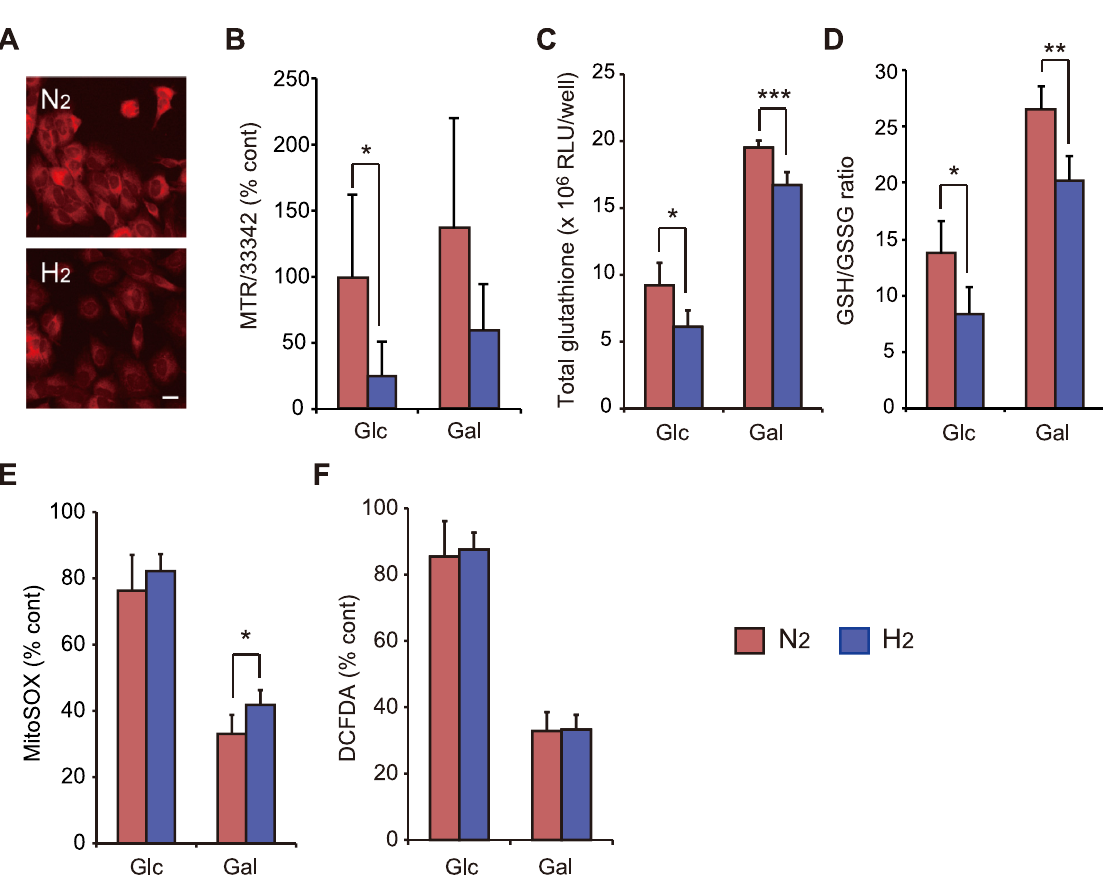
Fig 4. Induction of oxidative stressby H 2 treatment. SH-SY5Y cells were incubatedin culture medium containingeither Glc or Gal under N 2 - or H 2 -mixed gas for 18 h. (A, B) H 2 treatment attenuated staining with MTR, which was expressedas a percentage comparedwith cells not treated with mixed gases (considered as 100%). The scale bar is 20 μ m in (A). (C, D) H 2 treatment decreased the total glutathione and GSH levels. (E) H 2 treatment increasedsuperoxide formation in cells cultured in Gal- containing medium, which was expressedas a percentage comparedwith cells not treated with mixed gases (consideredas 100%). (F) H 2 treatment did not increaseDCFDA-indicated ROS, which was expressedas a percentage compared with cells not treated with mixed gases (consideredas 100%). * P < 0.05, ** P < 0.01, *** P <